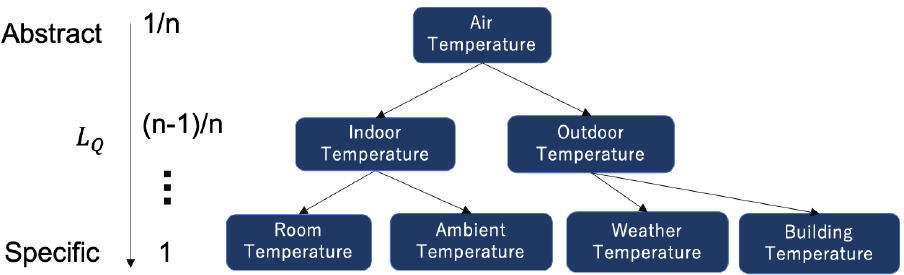
Figure 5. A subtree of quantity kind. The level of compatibility is calculated by calculating the ratio of the quantity class and its level in the ontology tree. The lower the subclass level, the device will be more specific, but the implementation will be stricter. The higher the level, the implementation will be more flexible.